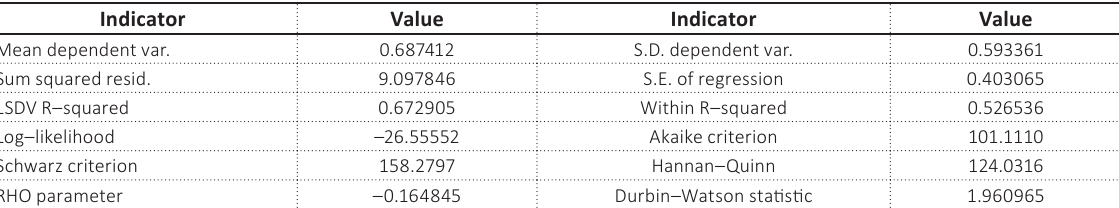
Source: Calculated via Gretl software